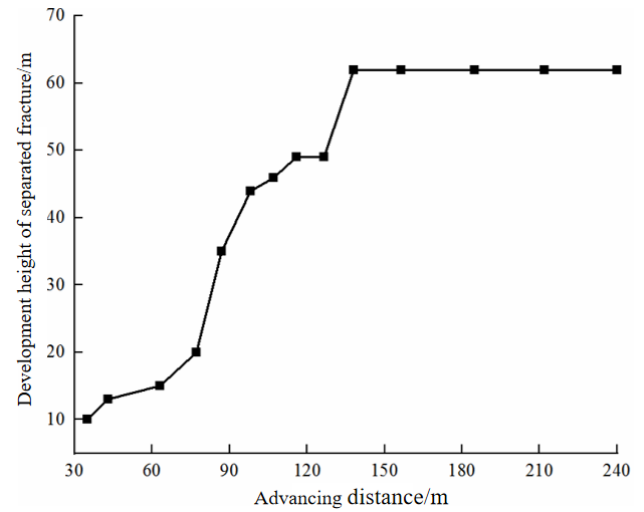
Figure 7. Variation curve of development height of separated fracture.